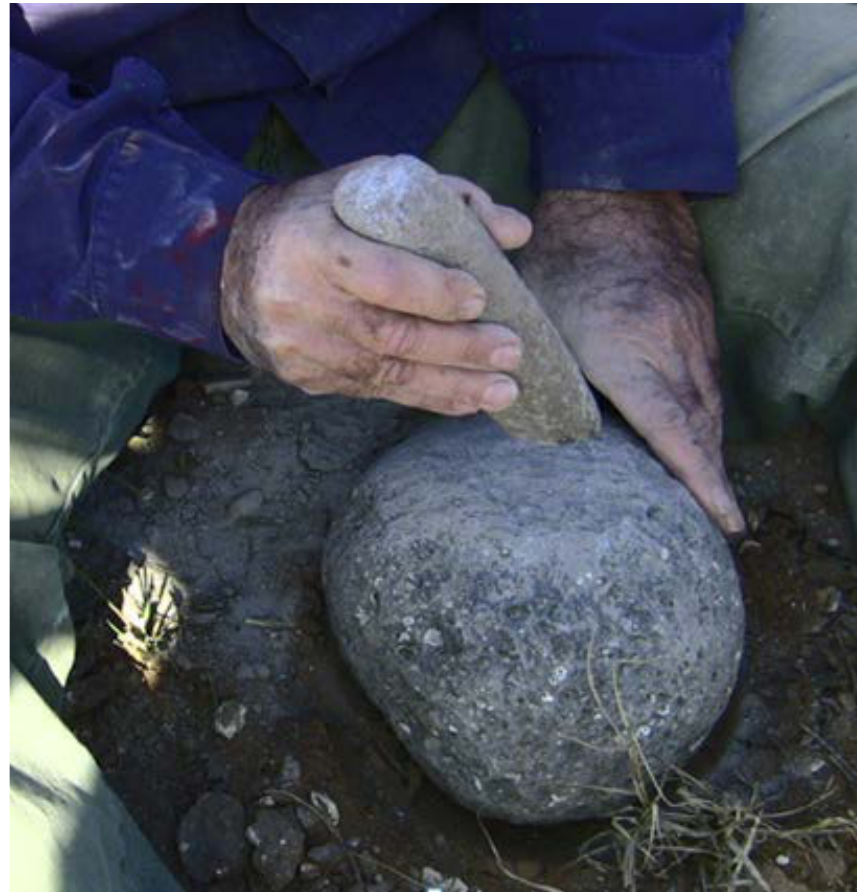
Figure 2. Pecking the surface of the cobblestone using a non-porous basalt